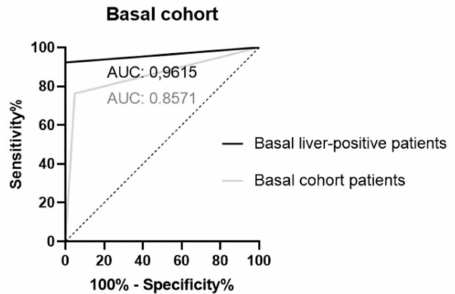
Figure 1. Receiver operating characteristic (ROC) curves for the BASAL COHORT patients (light grey, AUC: 0.8571, CI: 0.7335–0.9808) and for the subgroup of basal LIVER POSITIVE patients (black, AUC: 0.9615, CI: 0.8746–1.000).